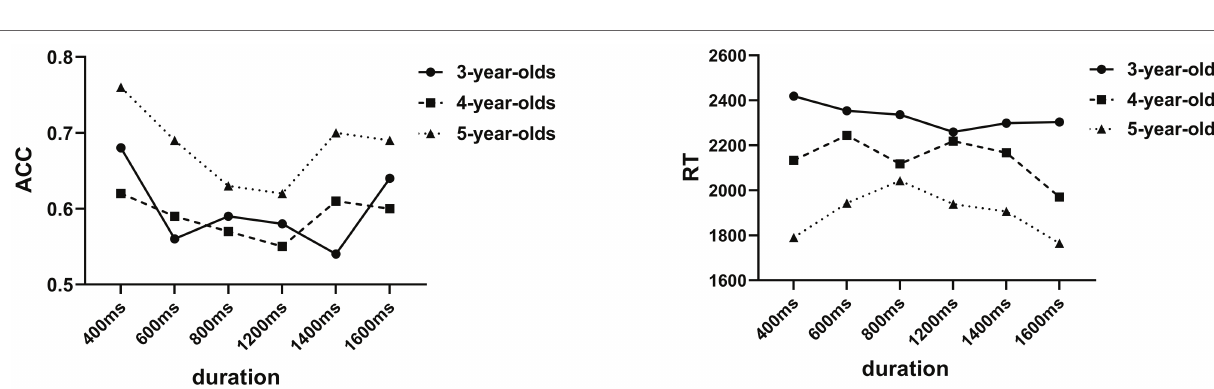
FIGURE 4 | ACC and RT under different durations and